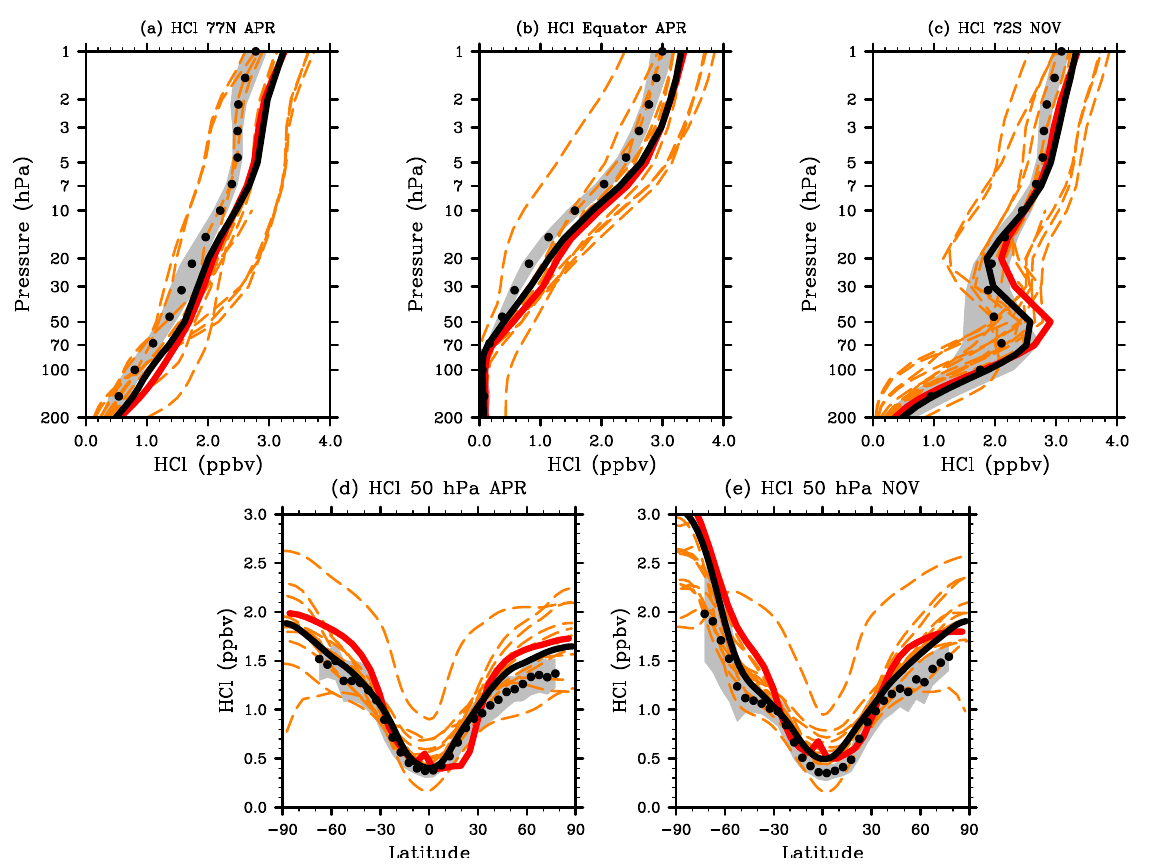
Fig. 5. Climatological (1992–2001) zonal-mean HCl mixing ratio (ppmv), for HALOE observations (black dots, with grey area showing ± 1 σ ), CNRM-ACM (red line), CNRM-CCM (black line), and CCMVal-2 REF-B1 models (dashed orange lines). Vertical profiles at (a) 77 ◦ N in April, (b) 0 ◦ N in April, and (c) 72 ◦ S in November. Zonal-means at 50 hPa in (d) April and (e) November.